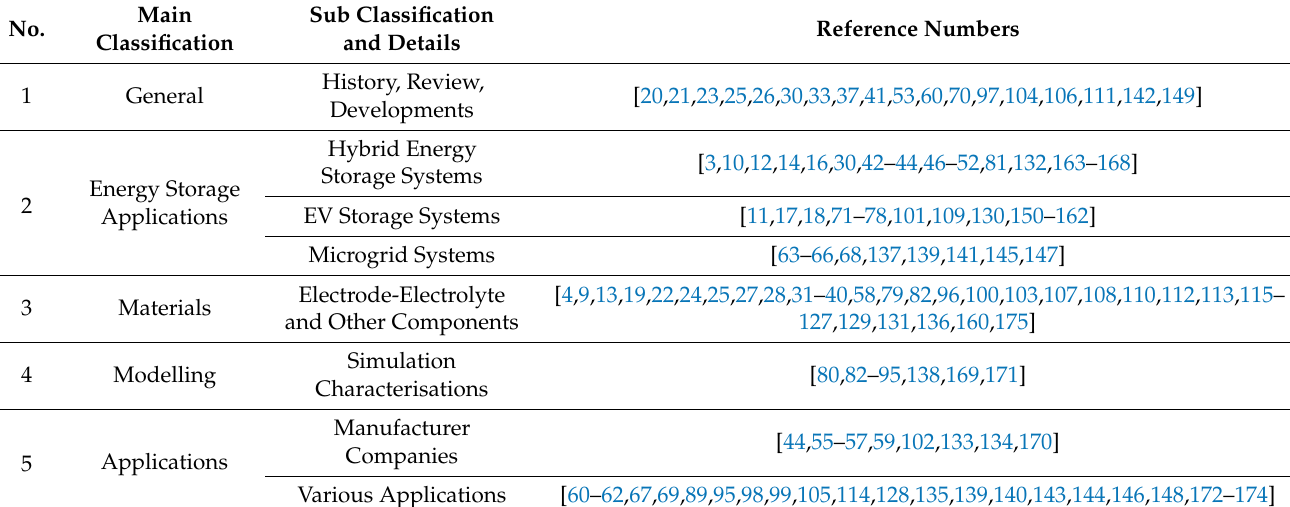
Table 4. Summary of literature classifications.